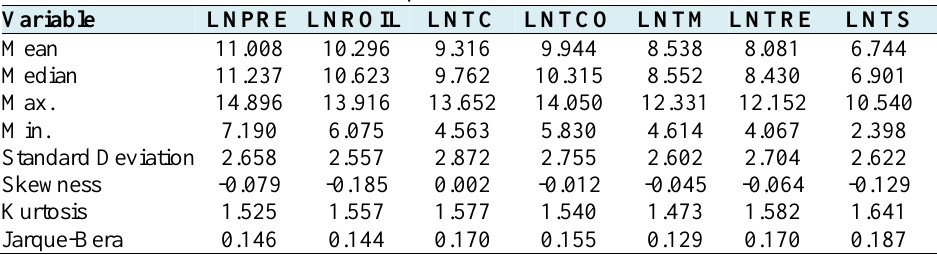
Table 1. Descriptive Statistics of Variables